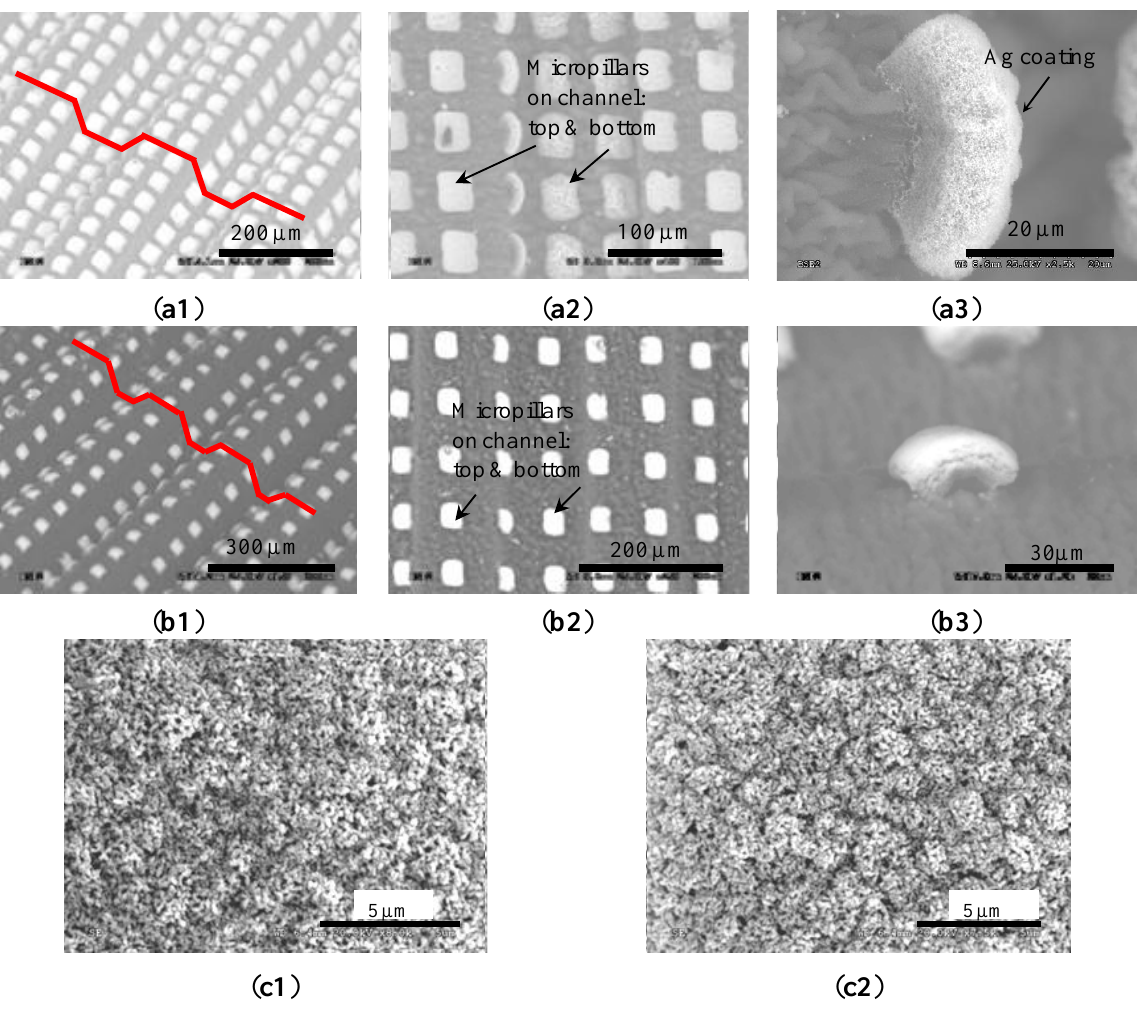
Figure 4. Two arrays of generated channels. ( a1 ) 3-D; ( a2 ) Top; and ( a3 ) Close-up views of Channels I; ( b1 ) 3-D; ( b2 ) Top; and ( b3 ) Close-up views of Channels II; Sub-micron wrinkles generated on the tops of Pillars. ( c1 ) I; and ( c2 ) II. (All are SEM